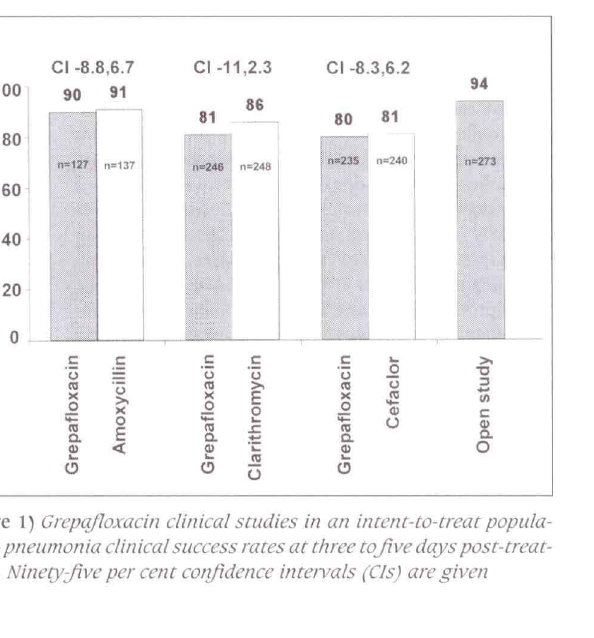
Figure I) Crepqfloxacin clinical srudies in an inrent-to-creat popula- cion - pneumonia clinical success races ar three to.Jive days posr-creat- menr. Nineryjive per cenr co,lfidence intervals (Cls) are